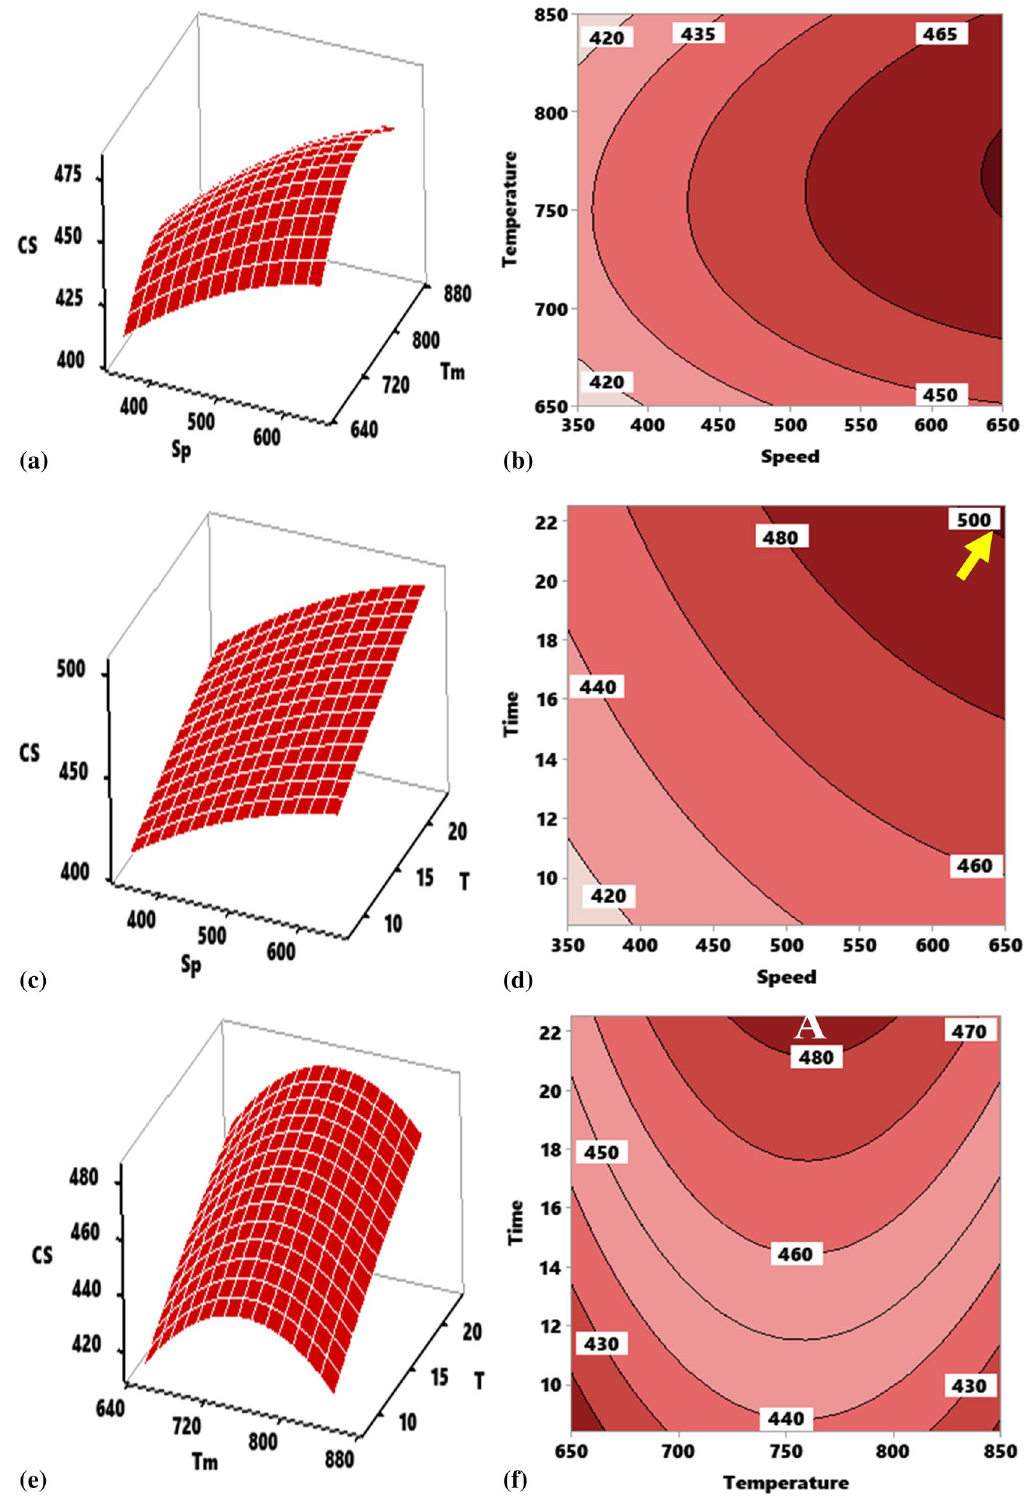
Figure 7. Influence of stirring parameter on compressive strength of developed composite as represented by response surface plot and contour plot for interactions. ( a , b ) Speed and temperature, ( c , d ) speed and time, ( e , f ) temperature and